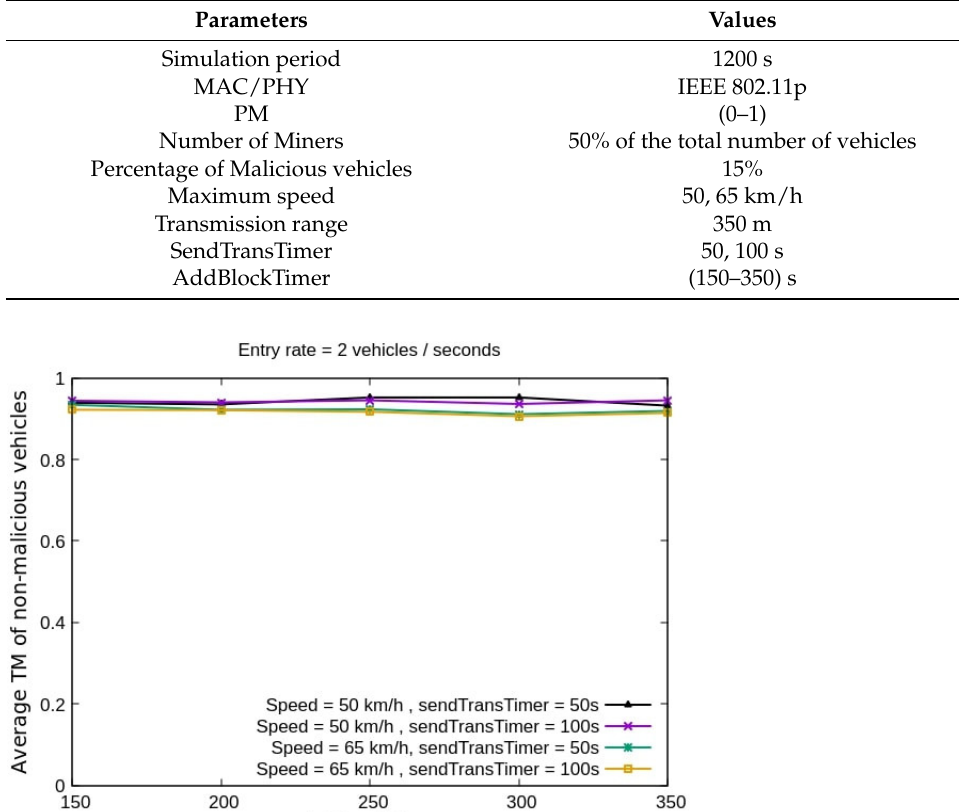
Table 1. Simulation Set up.